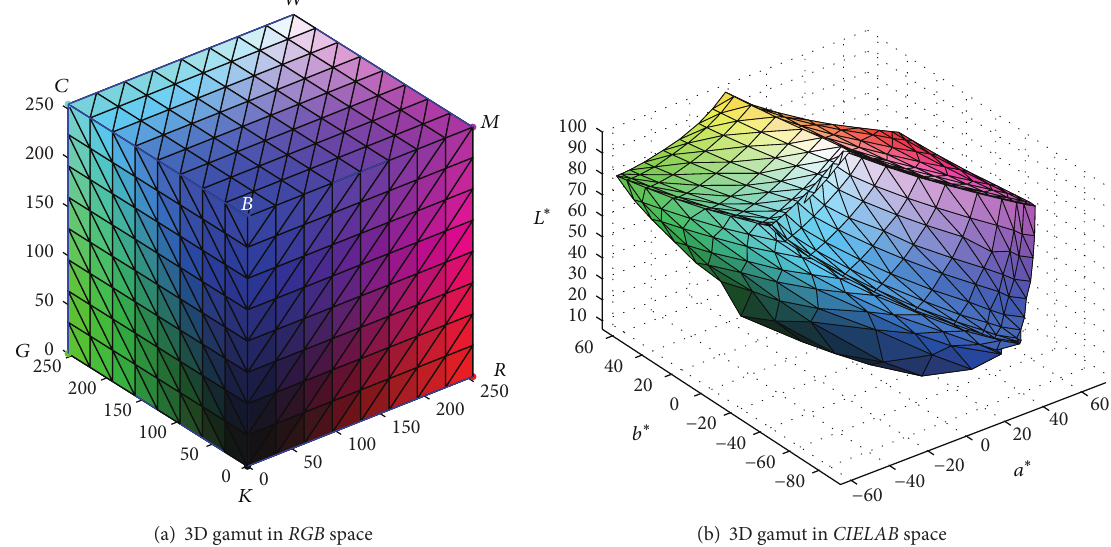
Figure 6: The continual 3D gamut in CIELAB of Toshiba